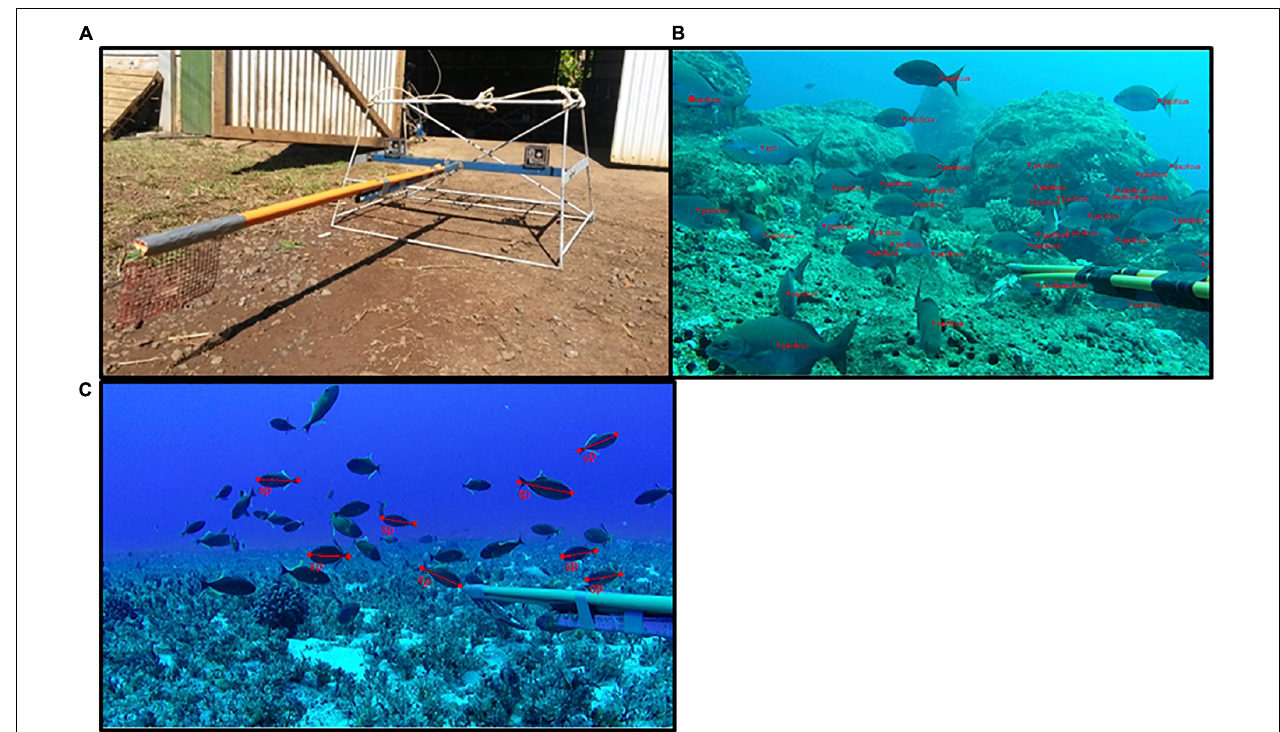
FIGURE 2 | (A) An example of the BRUVS frames deployed on Pitcairn, (B) a screenshot from EventMeasure video analysis showing the individual marking of Pacific chub in order to establish MaxN, and (C) screenshot from EventMeasure showing the measurement of individual crosshatch triggerfish. (A) top left, (B) top right, (C) bottom